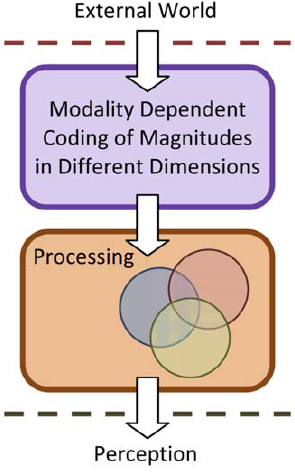
Figure 6. Mechanism of magnitude processing. This image highlights two points: different initial coding of information throughout the modalities and sharing of some brain areas among processing of magnitudes in two or more different dimensions (shown as circles).